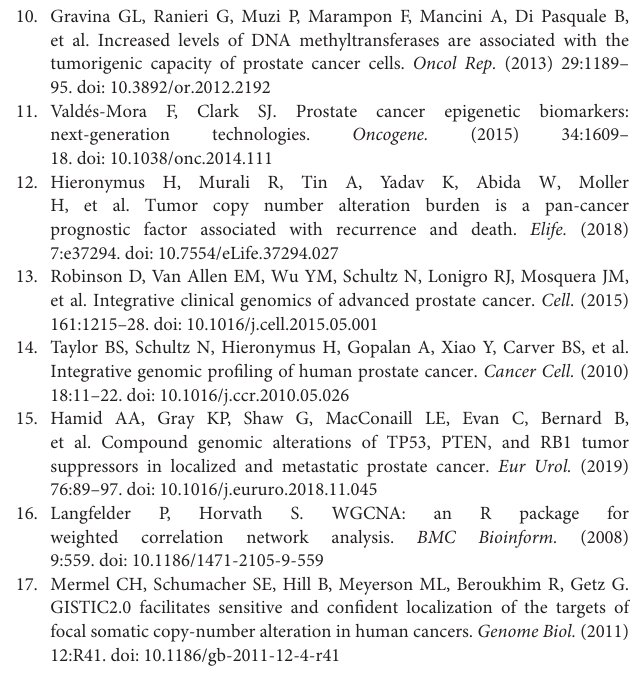
Supplementary Figure 1 | Protein–protein interaction (PPI) and validation of prognosis for identified biomarkers. (A) A co-expression between enhancer of zeste homolog 2 (EZH2) and Cyclin E2 (CCNE2), both of which play important roles in regulating cell cycle. (B–H) The prognostic value of identified genes in independent dataset GSE70769. Supplementary Figure 2 | The copy number variation (CNV) events in specific chromosomal regions. The higher G score represents for the greater probability of CNV events in that region. The previously identified genes were marked in the figure ( EZH2 : 7q36.1; CCNE2 : 8q22.1; RHPN1 : 8q24.3; TONSL : 8q24.3; EPHX2 :